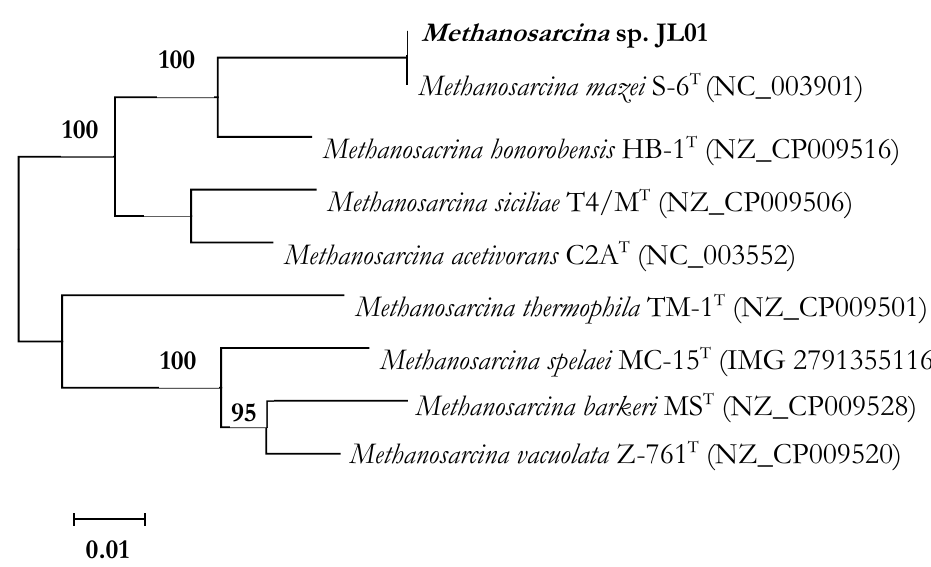
Figure 3. Maximum-likelihood phylogenetic tree of the strain JL01 based on a concatenated alignment of broadly conserved protein-coding genes (bootstrap = 1000). The sequence access numbers publicly available in Genbank are shown in parentheses. Evolutionary analyses were conducted in MEGA7.